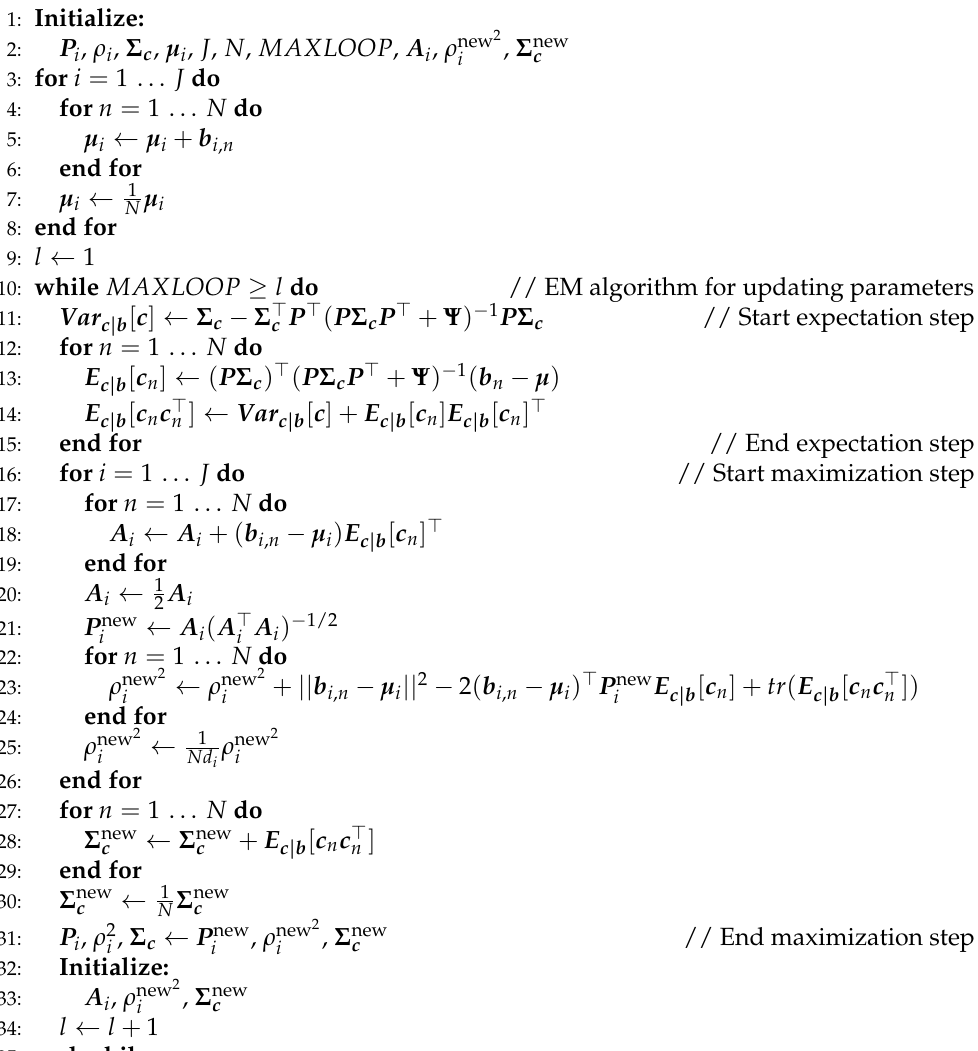
Algorithm 1 PGM for shared features c n